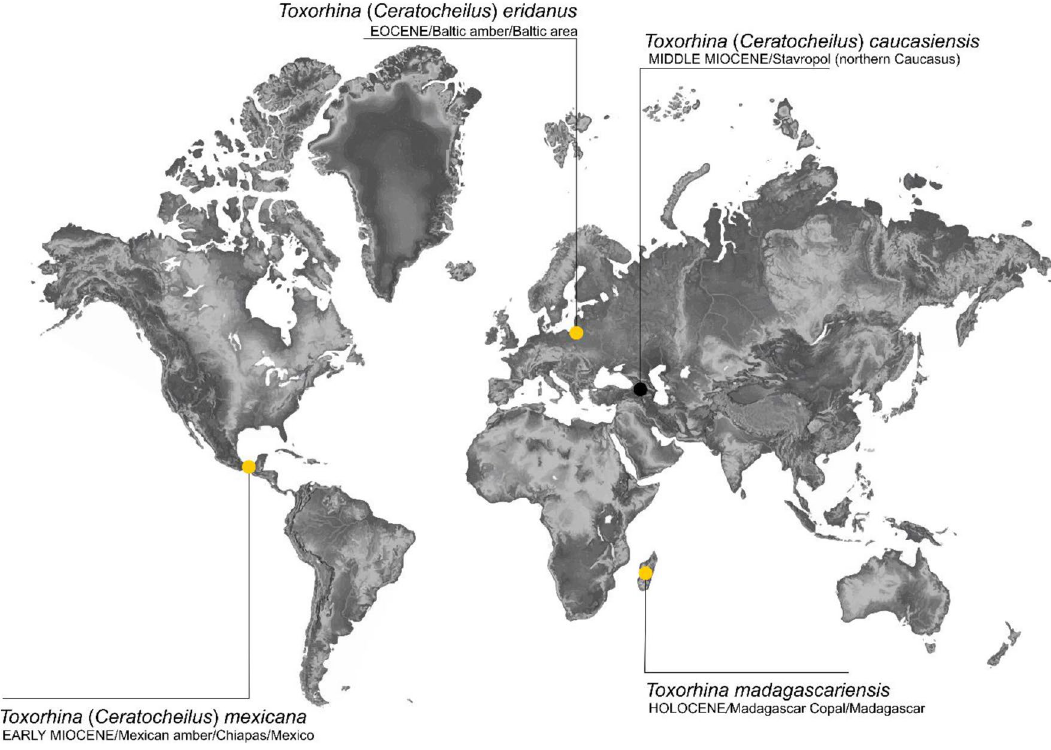
Figure 7. Map of the distribution of know localities of the representatives of the genus Toxorhina